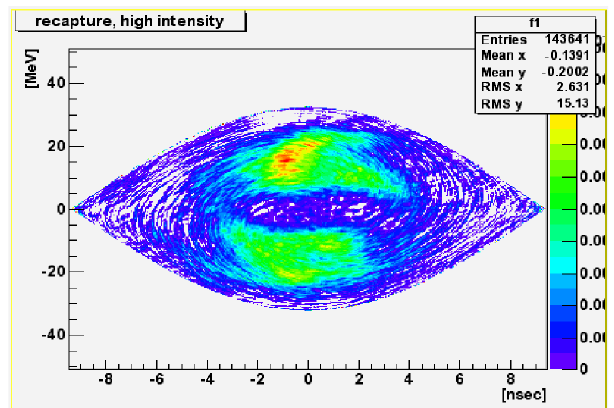
FIG. 5. Tomograph showing momentum offset against time for a recaptured bucket of slip stacked beam as reconstructed from resistive wall monitor signal after creation of 1 MV rf capture bucket. This figure is from Ref. [37].